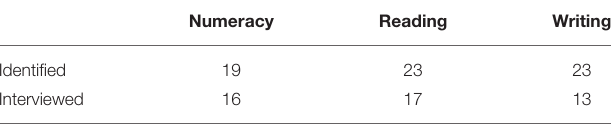
TABLE 2 | Number of pairs identified as discordant in each